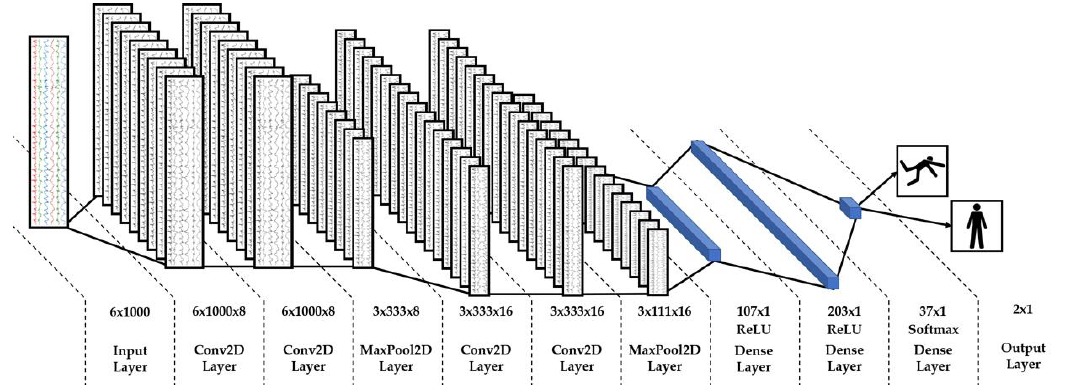
Figure 8. CNN-based AI algorithm used to predict the risk of fall. The input layer receives a 20 s frame from the 6 inputs of the DYSKIMOT sensor. The convolutional layers (Conv2D layer) extract meaningful features from its input and present it to the next stage. Pooling layers (MaxPool2D Layer) reduce the dimension of the feature space by retaining the meaningful inputs of its layer only. After several convolutional stages, the remaining features are injected in a three layers neural network (dense layer) in order to classify the participant’s frames (output layer). The risk of fall is the mean (ranging from 0 to 1) of prediction on all frames of the participant’s sequence. A mean greater than 0.5 denotes a participant with risk of